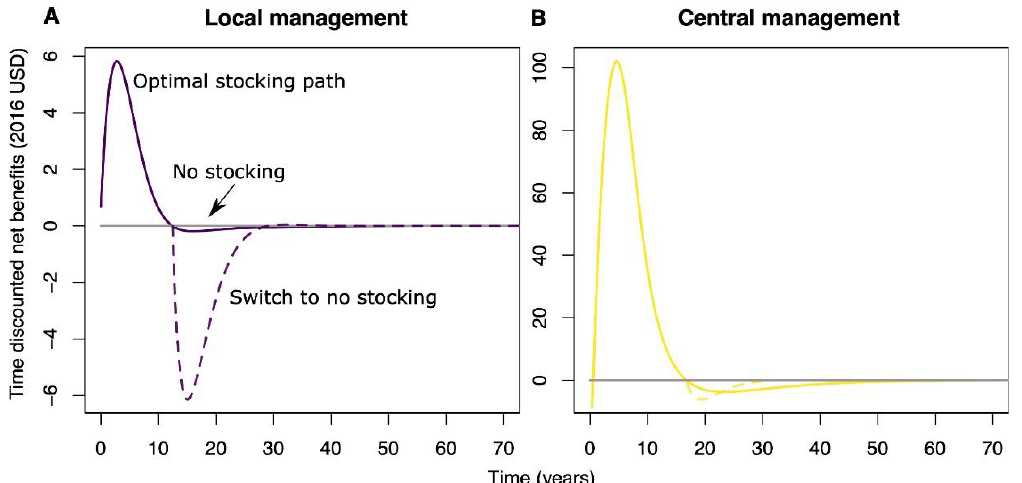
Figure A5.1. Welfare accrues during the transition to equilibrium, even though rents are dissipated at equilibrium, under (A) local management and (B) centralized